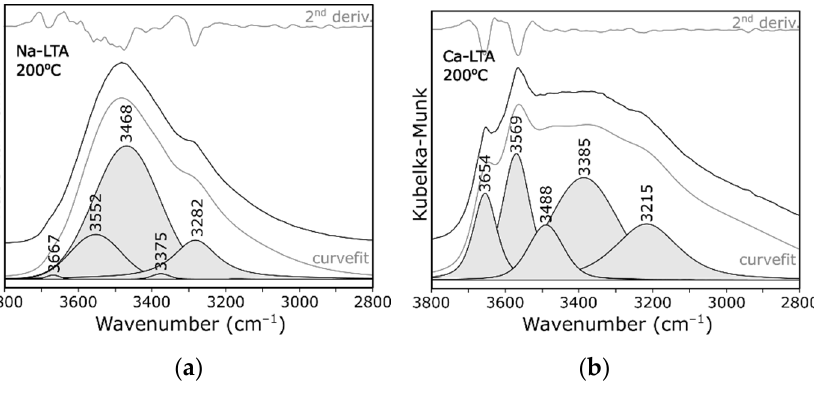
Figure 5. Decomposition of the spectra recorded at 200°C: ( a ) Na-LTA; and ( b ) Ca-LTA.